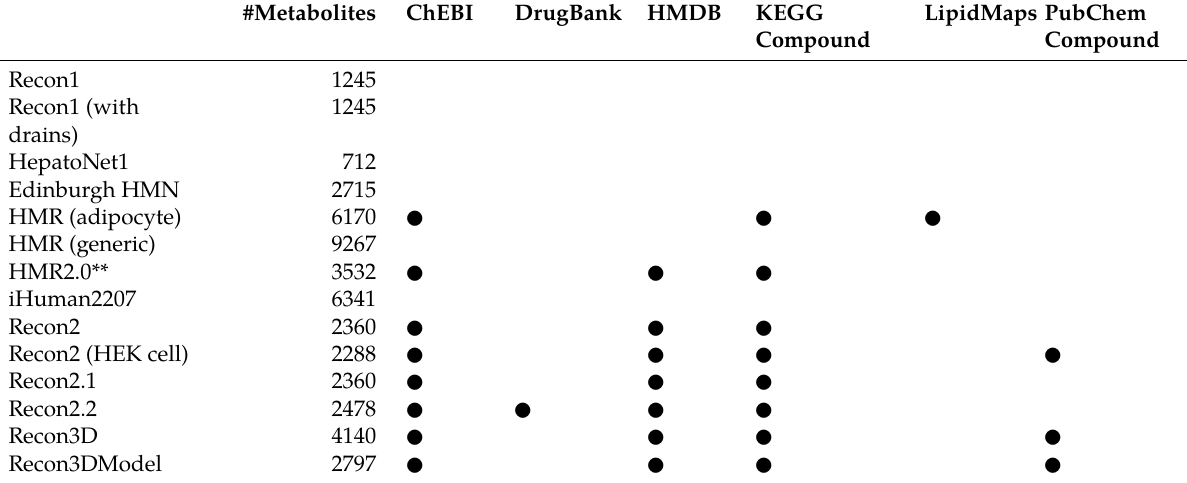
Table 1: Information for the human metabolic models used in this work.